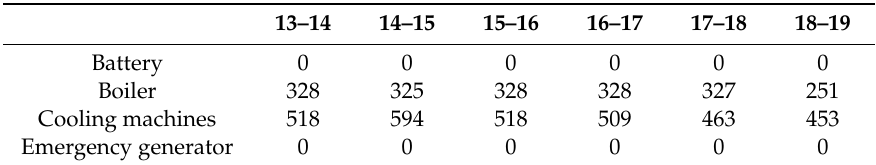
Table 8. Baselines for iteration 2.